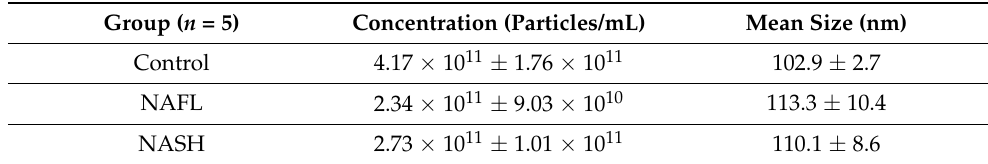
Table 2. Mean concentration and size of particles in qEV isolates from control, NAFL, and NASH subjects determined by nanoparticle tracking